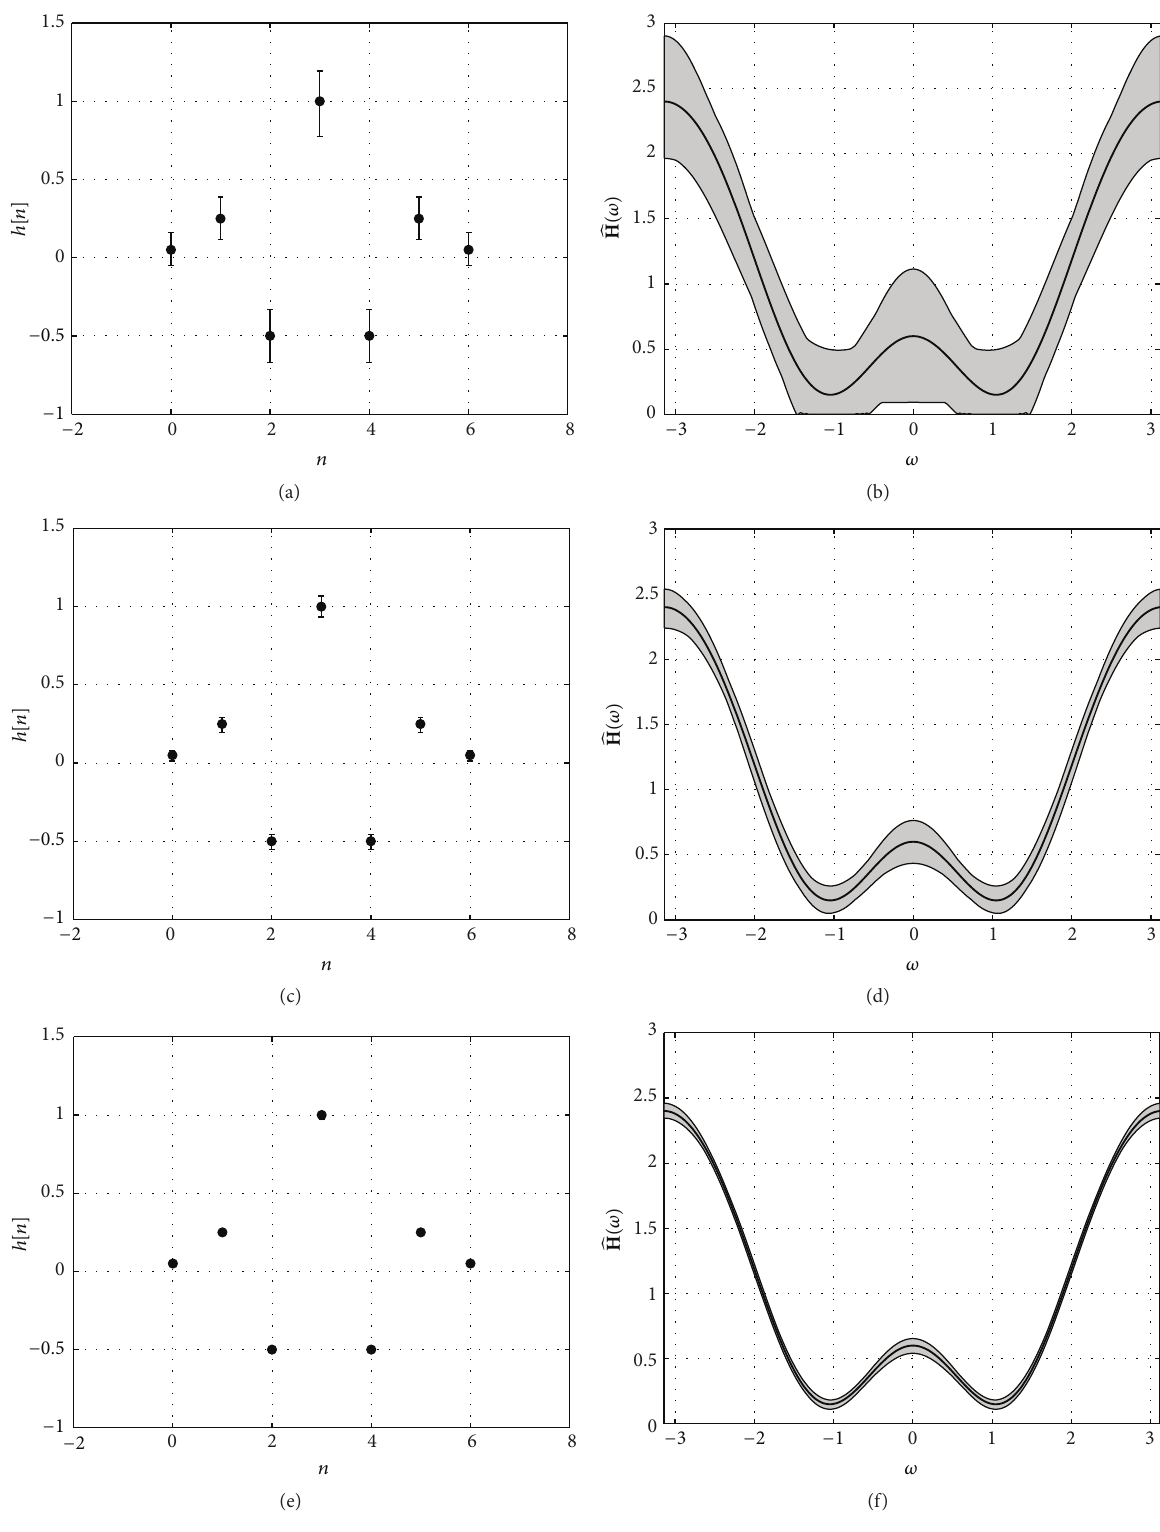
Figure 4: (a), (c), and (e) Estimated channel’s impulse response for SNR = 0dB, SNR = 10dB, and SNR = 20 dB, respectively. (b), (d), and (f) Estimated channel’s frequency response for SNR = 0dB, SNR = 10 dB, and SNR = 20 dB, respectively. In all cases the length of the channel is = 4 pilot subcarriers are used in the 𝐿 = 7 , the length of the DCT1 is 𝑁 = 256 , and 𝑁 𝑝